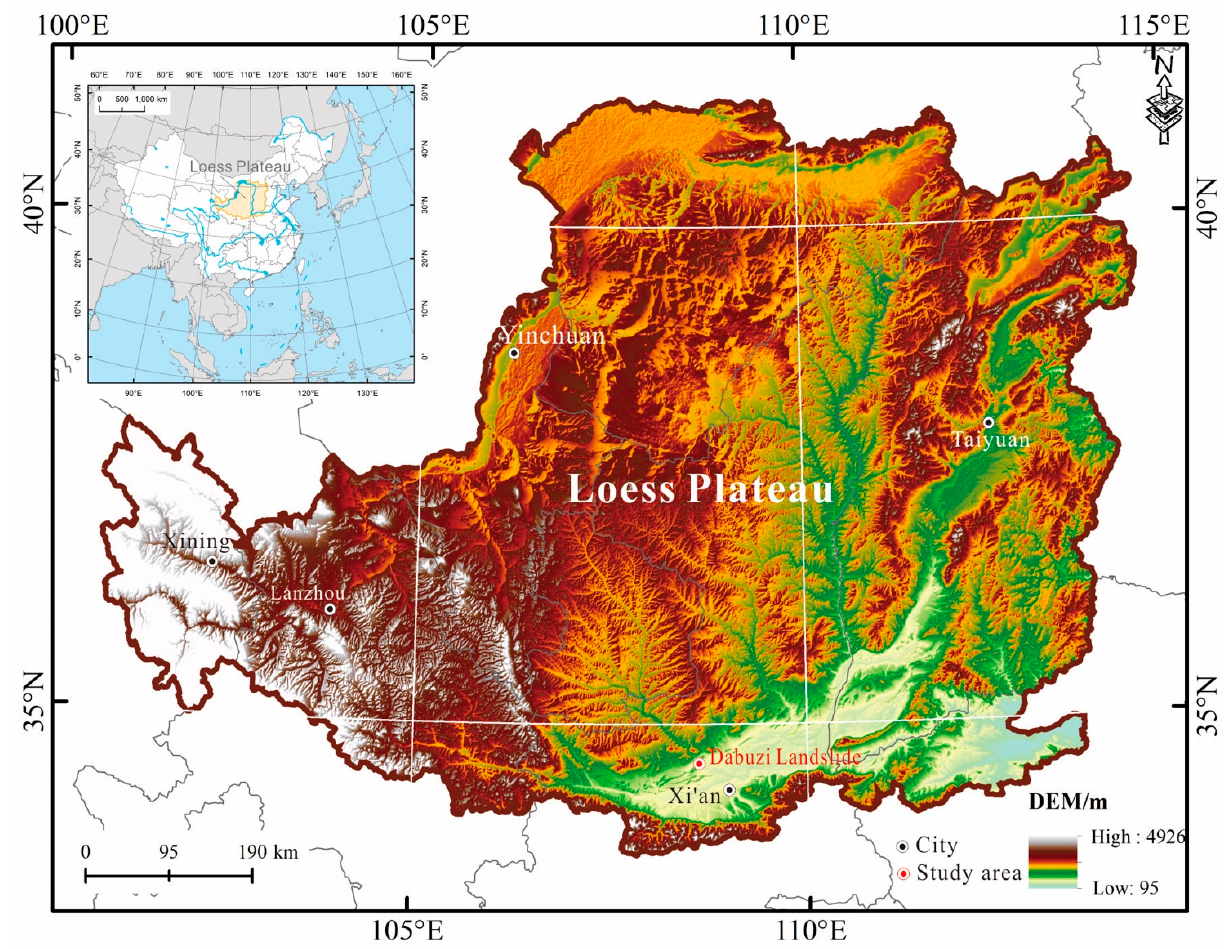
Figure 1. The study area.